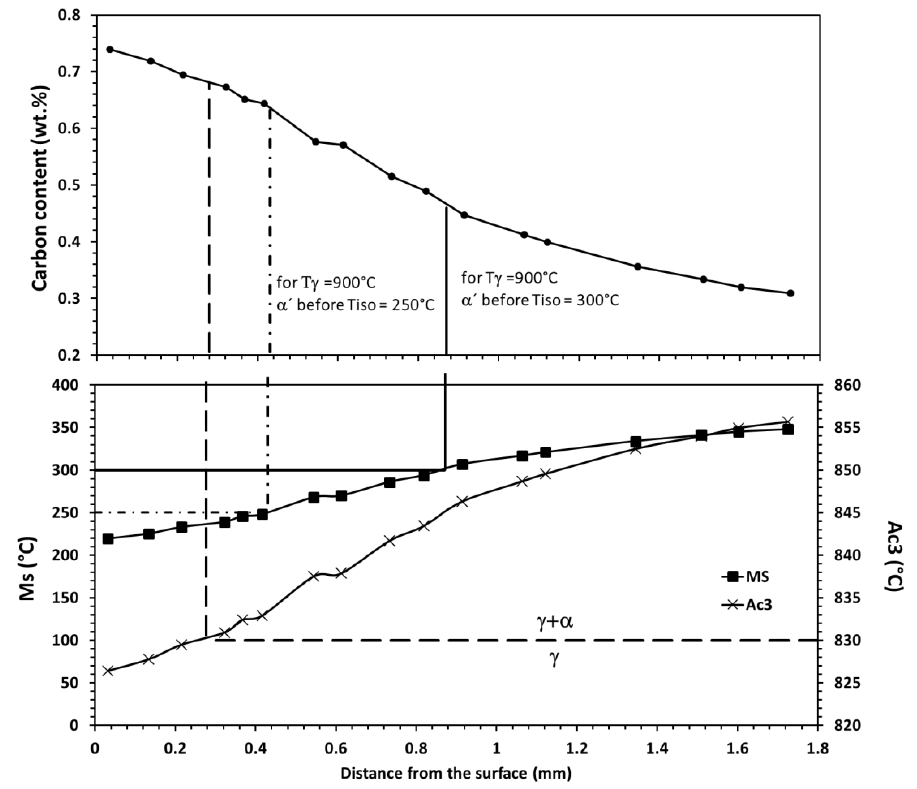
Figure 9. Carbon content distribution with depth from the carburized surface. Estimated Ms and Ac3 temperature as described in the main text.